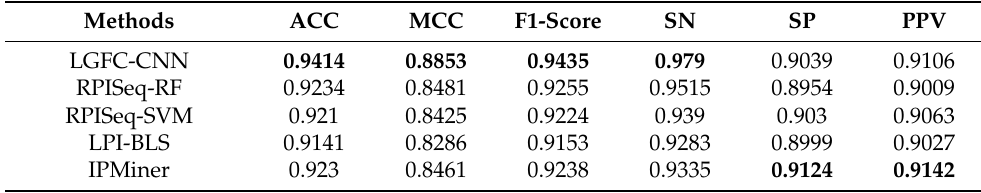
Table 2. The result of LGFC-CNN and other four methods on the RPI21850 dataset.